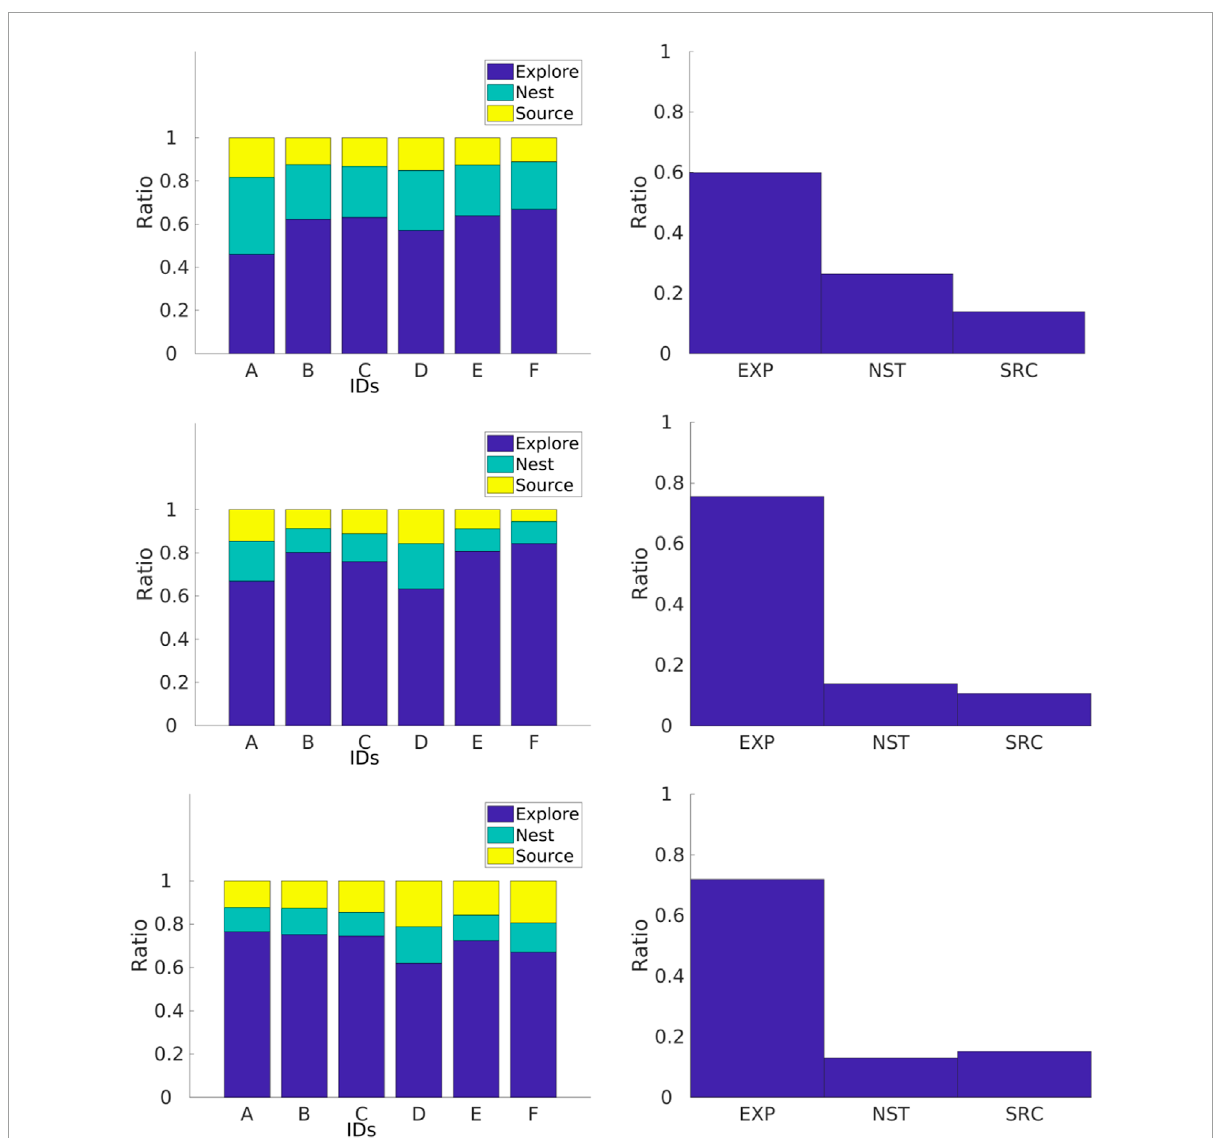
FIGURE 18 Individual performance for physical robots performing the NPS in three different arenas with dimensions of 1.0 m × 1.3 m (top row), 2.1 m × 1.2 m (middle row), and 2.4 m × 1.6 m (bottom two). The go-to-source rate is smaller than the go-to-nest rate as the arena becomes smaller.